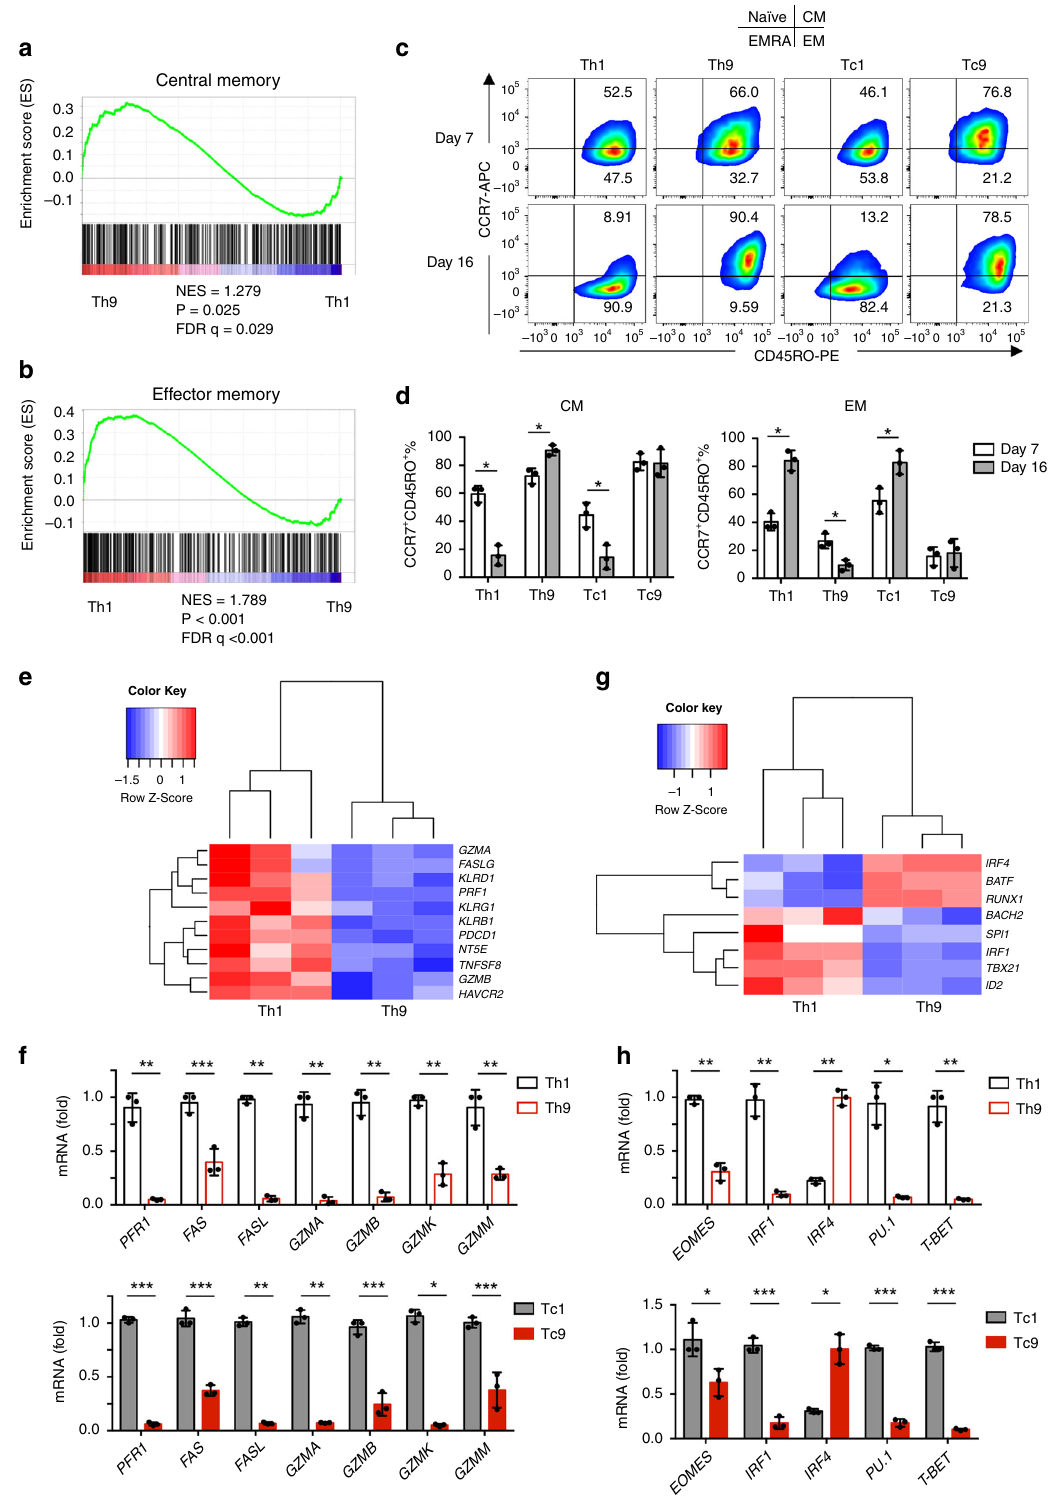
Fig. 3 In vitro generated T9 CAR-T cells exhibit T cm -like and less exhausted phenotypes. GSEA results showing a central memory or b effector memory gene signatures of polarized Th9 or Th1 cells. c Representative fl ow plots and d pie charts ( n = 3 donors) showing CCR7 or CD45RO expression on CAR-T cells at days 7 and 16. Cells were pre-gated for GFP + CD3 + CD4 + or GFP + CD3 + CD8 + T cells. e Heatmap showing the expression of exhaustion and cytolytic genes in Th9 or Th1 CAR-T cells assessed by RNASeq. f Expression levels (relative to GAPDH) of exhaustion and cytolytic genes in Th1 or Th9 (upper panels), and Tc1 or Tc9 (lower panels) CAR-T cells measured by qPCR. g Heatmap illustrating the expression of genes of transcription factors in Th9 or Th1 CAR-T cells. h Expression levels (relative to GAPDH) of transcription factor genes in Th1 or Th9 (upper panels), and Tc1 or Tc9 (lower panels) CAR-T cells measured by qPCR, f and h were performed with three biological replicates and data shown are representative of two independent experiments. Data are presented as mean ±SD. * P <0.05, ** P < 0.01, and *** P <0.001, two-sided Student ’ s t -test. Source data are provided as a Source Data fi